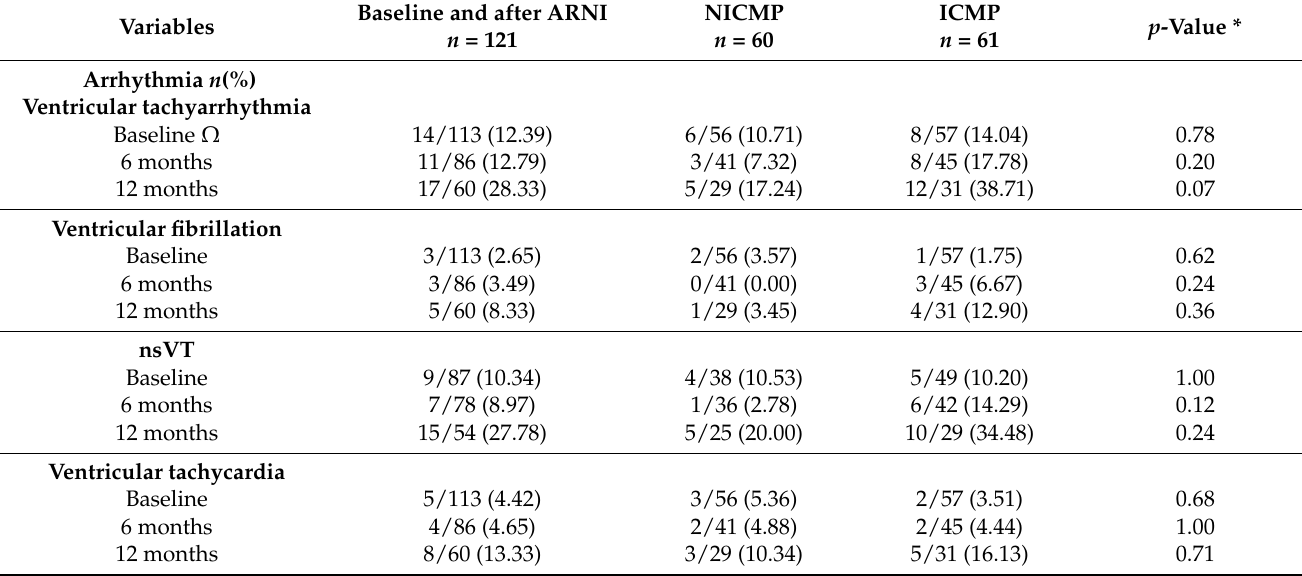
Table 2. Tachyarrhythmia occurrence in ICMP and NICMP patients at baseline, 6-, and 12-month follow-ups.